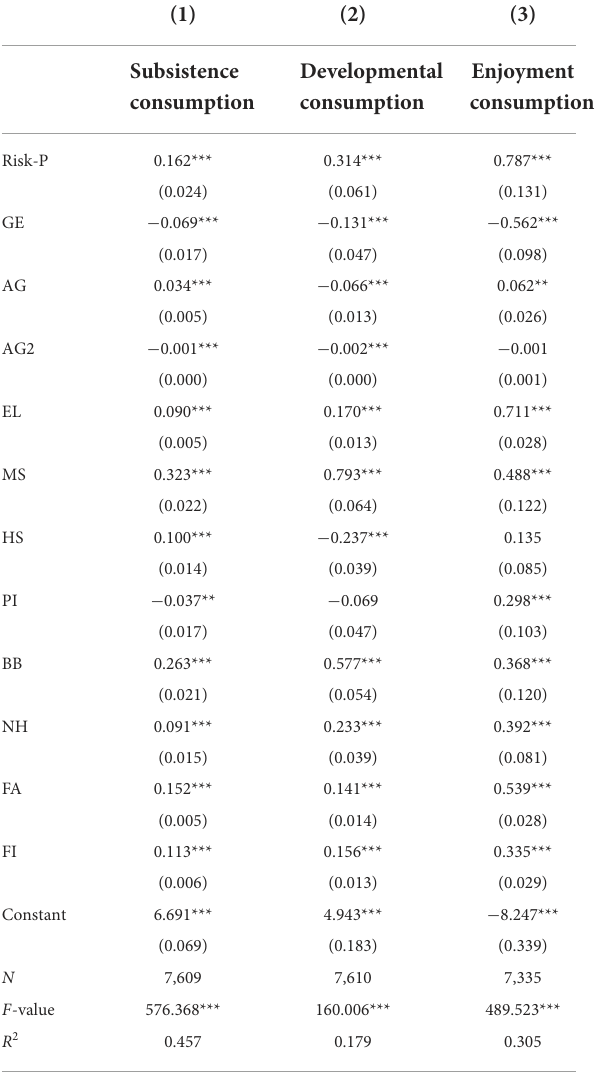
TABLE 12 The impact of risk neutrality on household total consumption